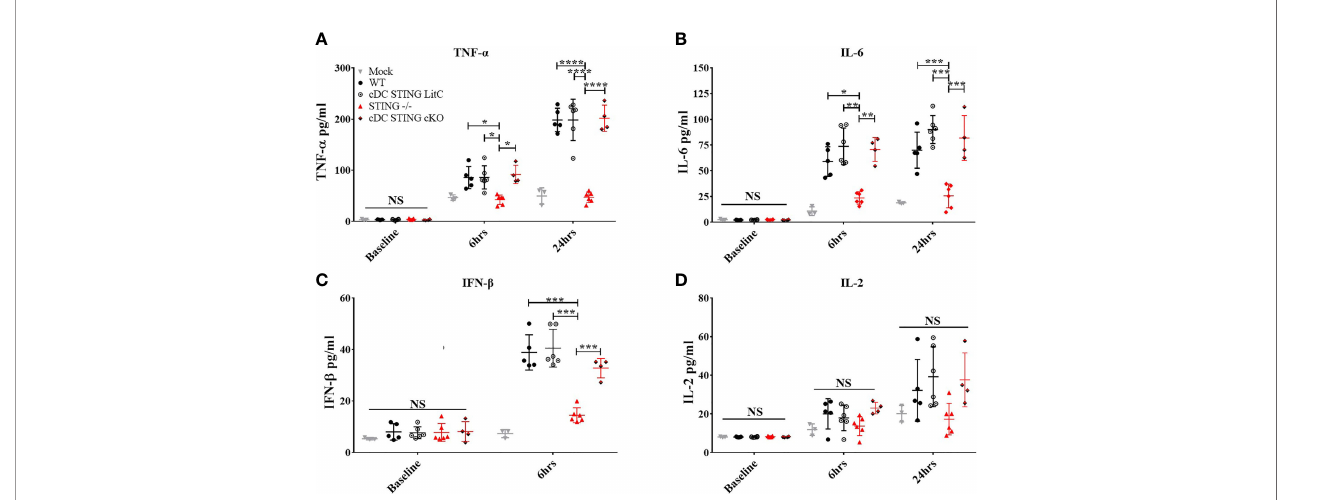
FIGURE 4 | STING is required for DNA vaccine induction of innate pro-in fl ammatory cytokines, but not within cDCs. WT, STING -/- , cDC STING cKO , and cDC STING LitC mice IM/EP vaccinated with pNP. Sera was collected prior to vaccination (baseline), 6 hours (6hrs) and/or 24 hours (24hrs) post-vaccinations, and sera concentrations of (A) TNF- a , (B) IL-6, (C) IFN- b and (D) IL-2 were calculated. Three independent experiments were carried out consisting of 3-6 mice; representative data are the averages± SD of 3-6 mice/genotype. At each timepoint a one-way ANOVA was performed, *p < 0.05, **p < 0.01, ***p < 0.001,****p < 0.0001 and NS, not signi fi